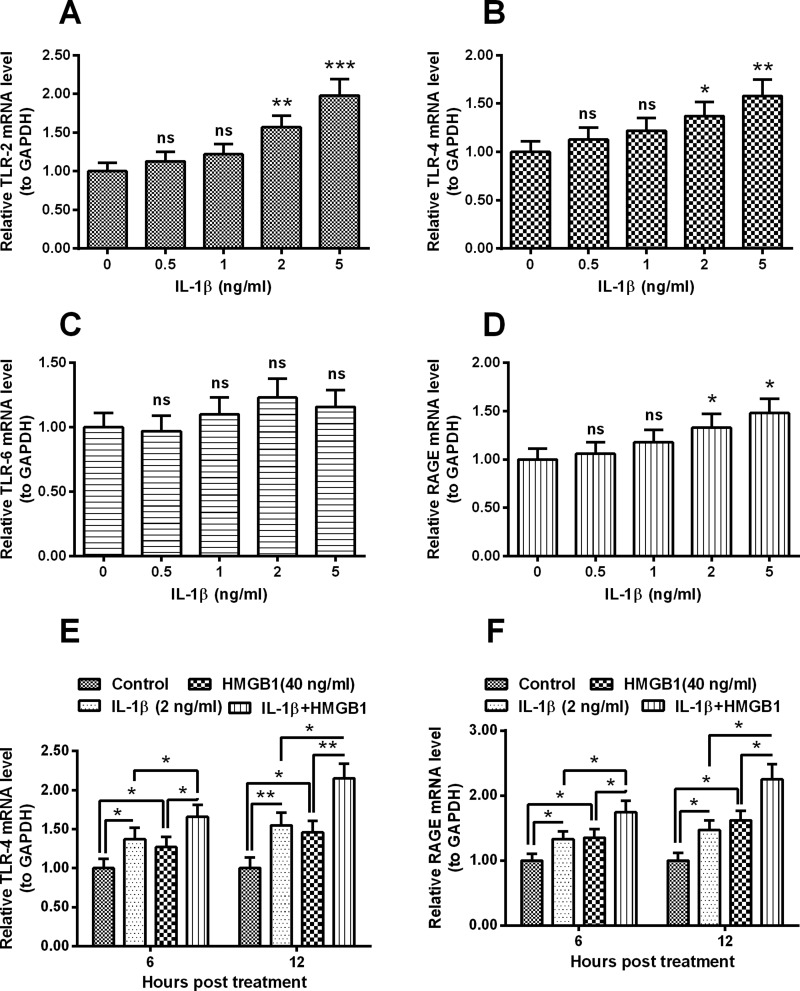
Expression of TLRs and RAGE in mRNA levels in the IL-1β- or/and HMGB1-treated disc annulus fibrosus cellsDisc annulus fibrosus cells were treated with 0, 0.5, 1, 2 or 5 ng/ml IL-1β for 12 h, then the relative mRNA levels of TLR-2 (A), -4 (B), -6 (C) or RAGE (D) to GAPDH were examined with RT-qPCR method; (E and F) relative mRNA levels of TLR-2 and -4 (E), TLR-6 and RAGE (F) to GAPDH in the IL-1β- or (and) HMGB1-treated (for 12 h) disc annulus fibrosus cells. Results are presented as mean ± S.E.M. for quartic independent experiments. P values in A–D were calculated by the parametric ANOVA (Tukey–Kramer post hoc) test; and P value in E–F was calculated by Student t test. *P<0.05, **P<0.01, ***P<0.001 or ns: no significance.